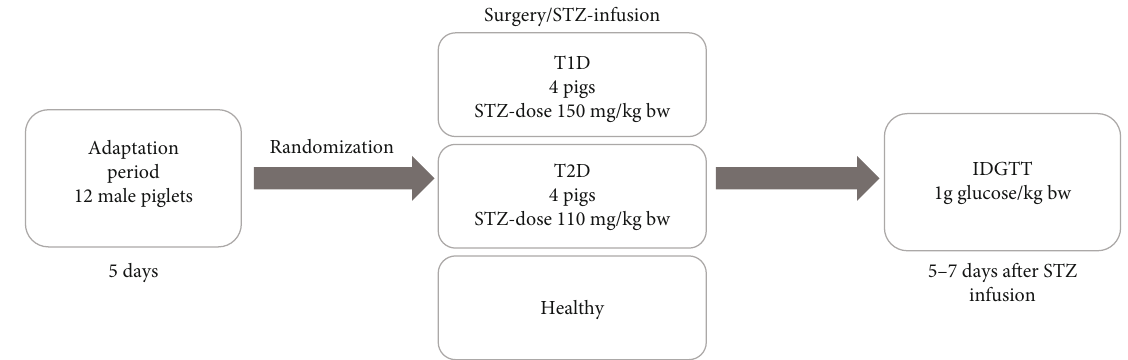
Figure 1: Schematic representation of the in vivo study design. IDGTT: intraduodenal glucose tolerance test; T1D: STZ-induced type 1-like diabetes mellitus; T2D: STZ-induced type 2-like diabetes